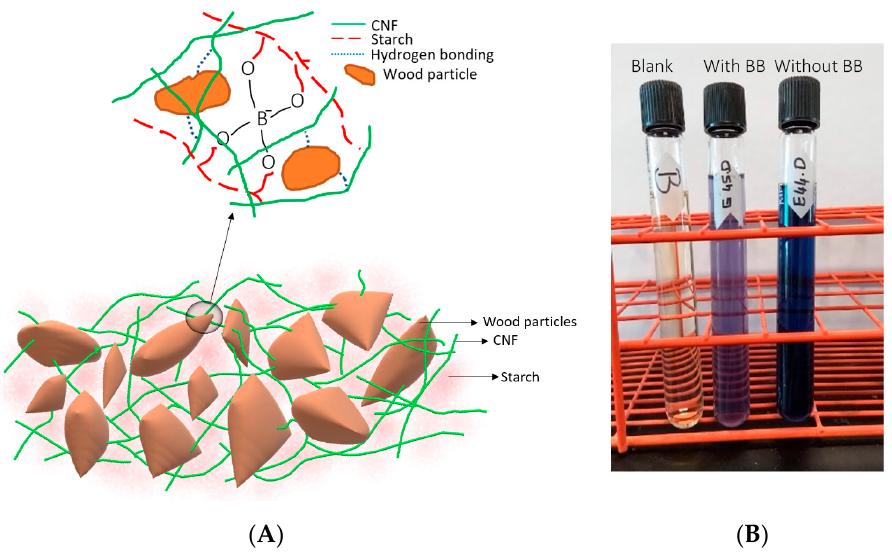
Figure 11. ( A ) Schematic representation of the interactions between the various components of the panel and ( B ) Color intensity after adding the iodine-potassium iodide to the filtrate for treated and untreated samples. (BB: Boric acid and borax mixture).